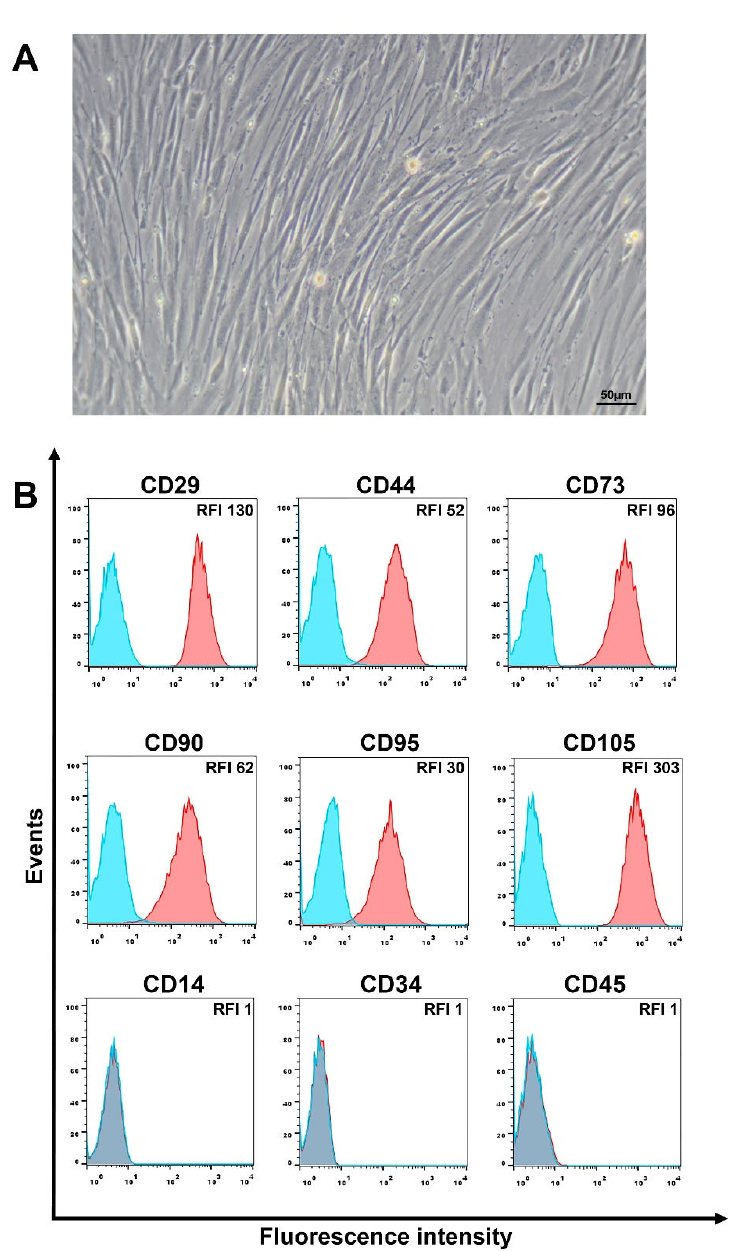
Figure 1. Morphology and phenotype of L ‐ MSCs. ( A ) Phase ‐ contrast microscopy of L ‐ MSC culture. Cell cultures were photographed using the Axiovert 40 CFL (Carl Zeiss, Oberkochen, Germany) inverted microscope and the Nikon D5000 digital camera (Nikon, Tokyo, Japan). ( B ) Expression of MSC markers, CD95, and immune cell markers on the surface of L ‐ MSCs. The blue peaks correspond to the control unstained cells; the red peaks to the cells stained with the corresponding anti ‐ bodies. Representative data for one culture of L ‐ MSCs are presented. RFI—relative fluorescence in ‐ tensity.